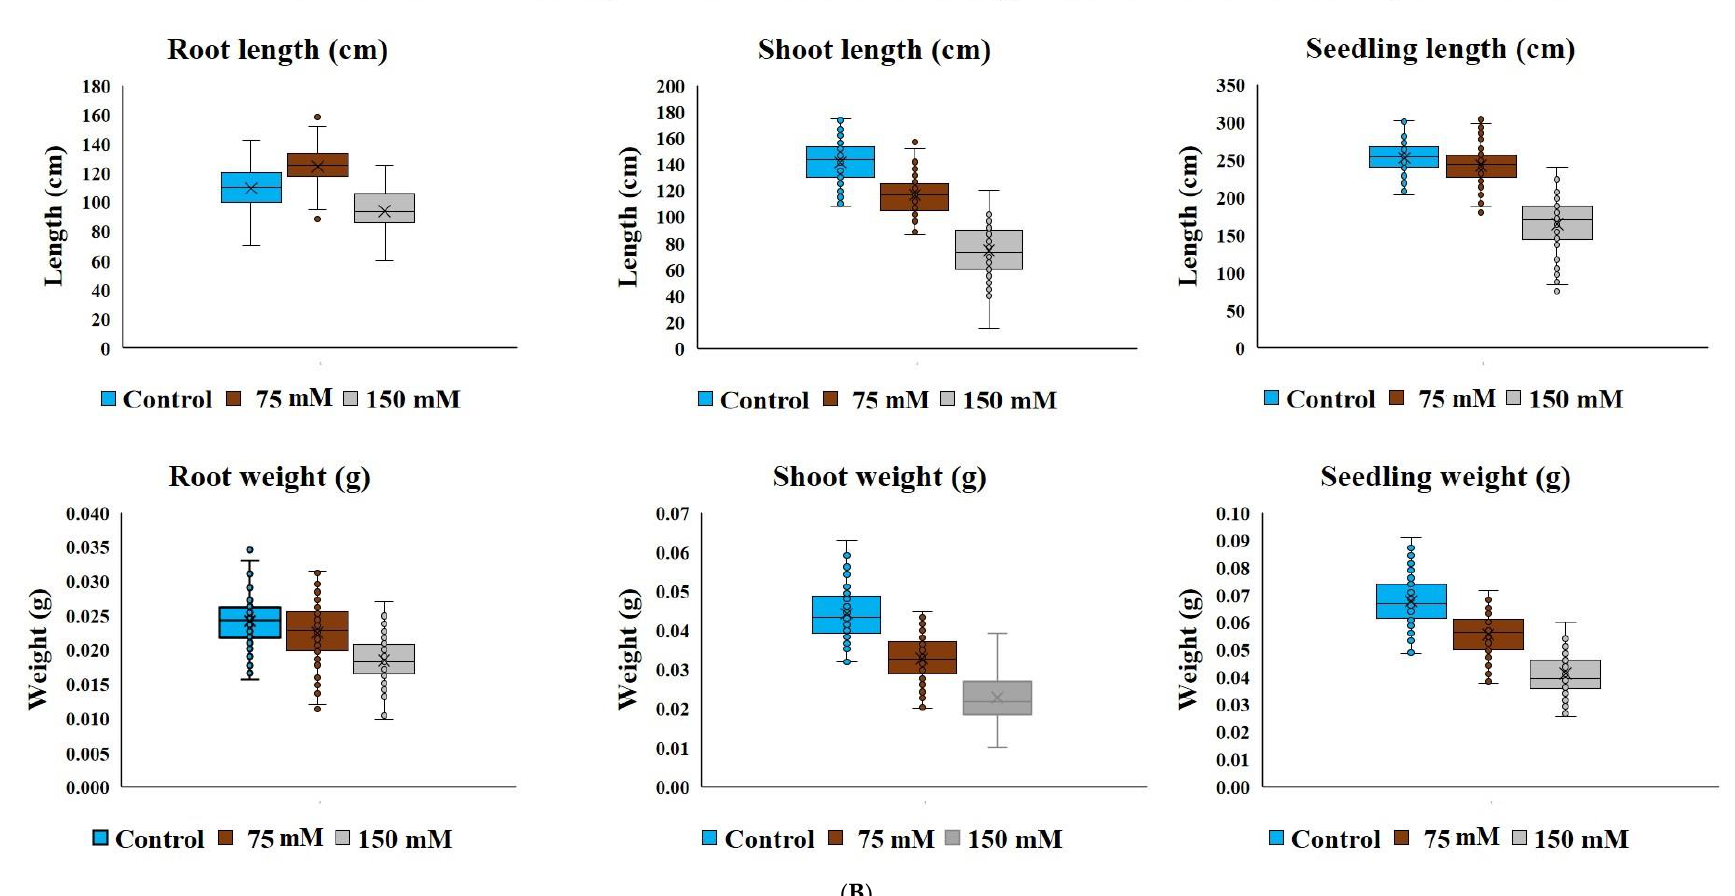
Figure 1. ( A ) Block plots for seedling survival traits of CM72/Gairdner DH populations under different levels of NaCl concentrations (mM) grown in hydroponic solutions after germinating under the same conditions; ( B ) Block plots for seedling survival traits of selected barley accessions under different levels of NaCl concentrations (mM) grown in hydroponic solutions after germinating under the same stress.